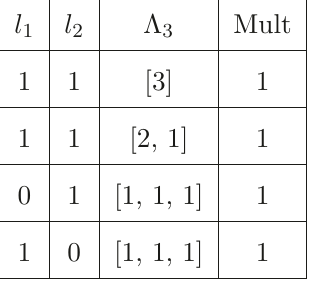
Table 6 . Results for n = 3 fields and k = 2 derivatives.